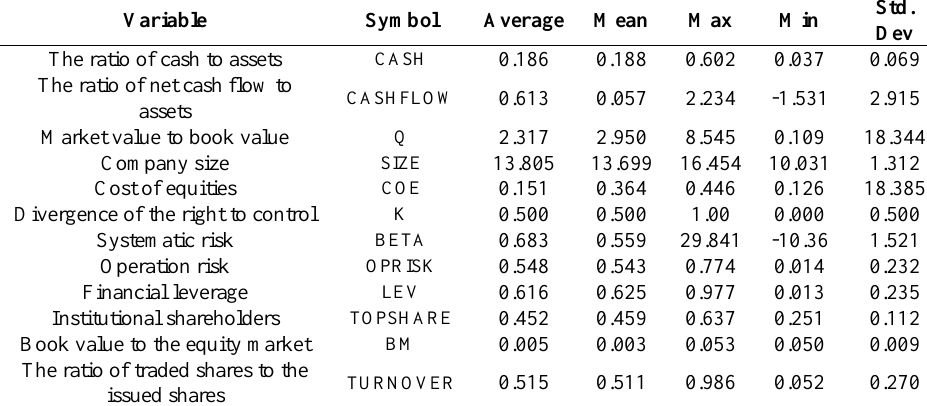
Table 1. Descriptive statistics of